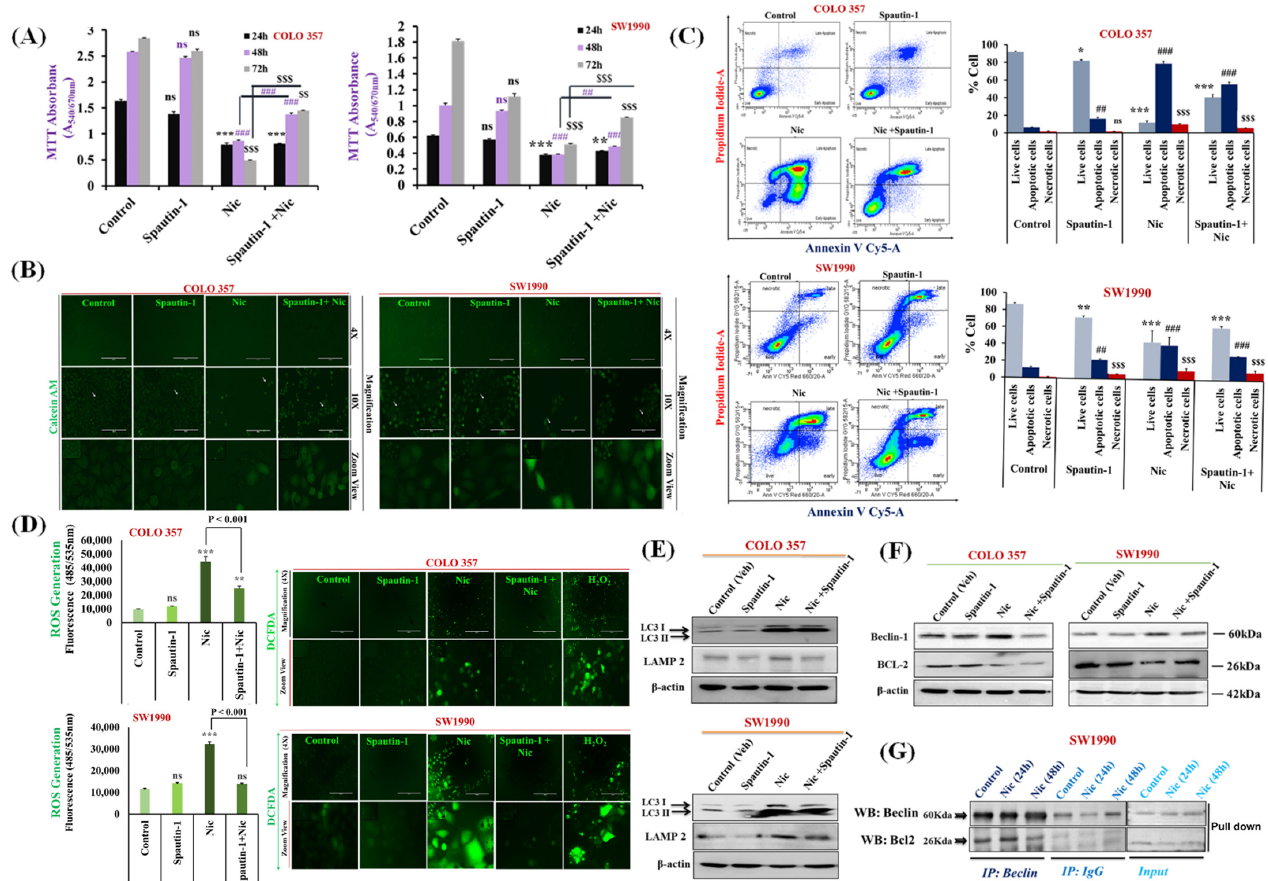
Figure 4. Nic-induced autophagy leads to PC cell death by disrupting Beclin1–BCl2 interaction. ( A ) Effect of functional blockage of autophagy via spautin-1 on Nic-treated PC cells resulted in growth promotion. COLO 357 and SW1990 cells were pretreated with spautin-1 for 2 h, followed by Nic (10 µM) for 24, 48, and 72 h and cell viability was assessed by MTT assay. Values are expressed as mean ± SEM ( n = 3), p values: *** p < 0.001, ** p < 0.01 vs. control (24 h); p values: ### p < 0.001, ## p < 0.001 vs. control (48 h); p values: $$$ p < 0.001, $$ p < 0.001 vs. control (72 h). ( B ) Representative